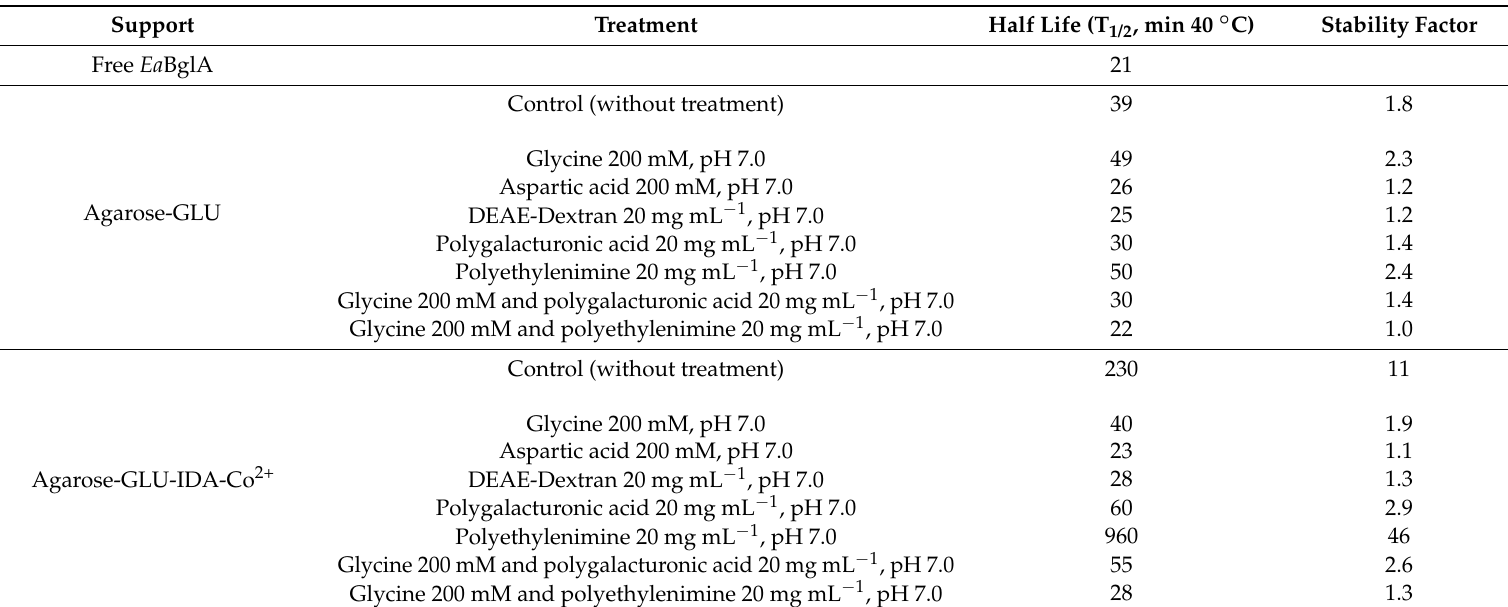
Table 3. Time course of thermal stability of different immobilized Ea BglA